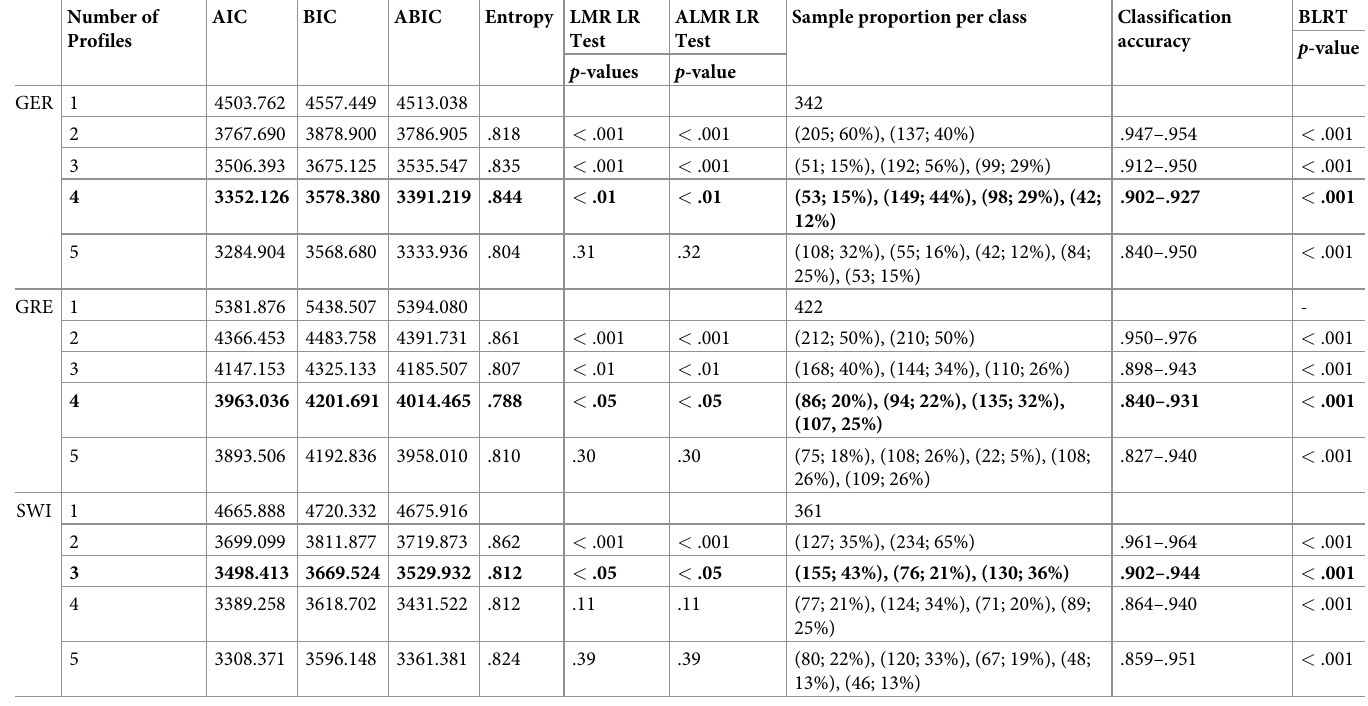
Table 2. Model fit indices for latent profile analyses of Germany, Greece, and Switzerland. Number of Profiles